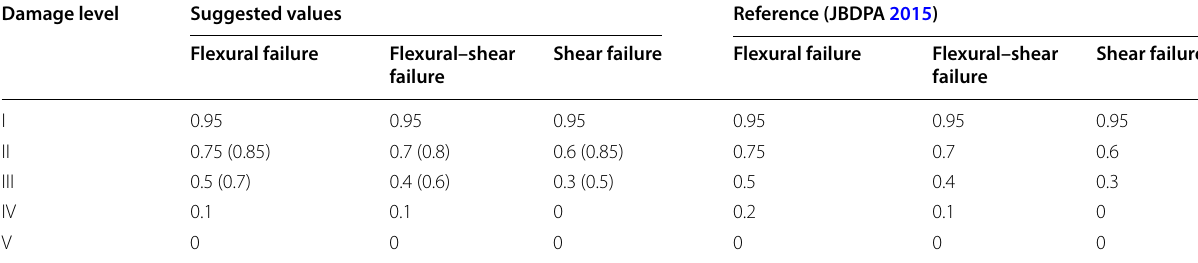
Table 9 Suggested reduction factors of energy dissipation capacity for RC column members.